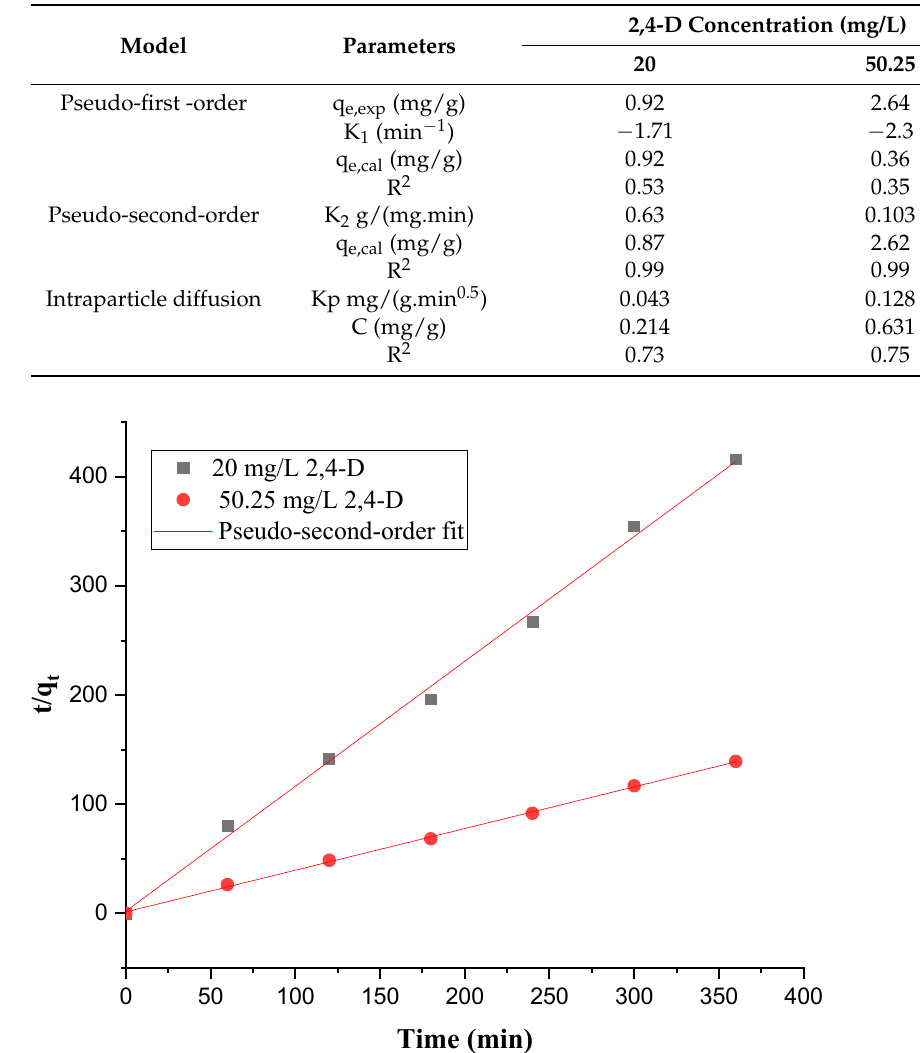
Table 3. Pseudo-first-order, pseudo-second-order, and intraparticle diffusion characteristics of 2,4-D adsorption on TMS.